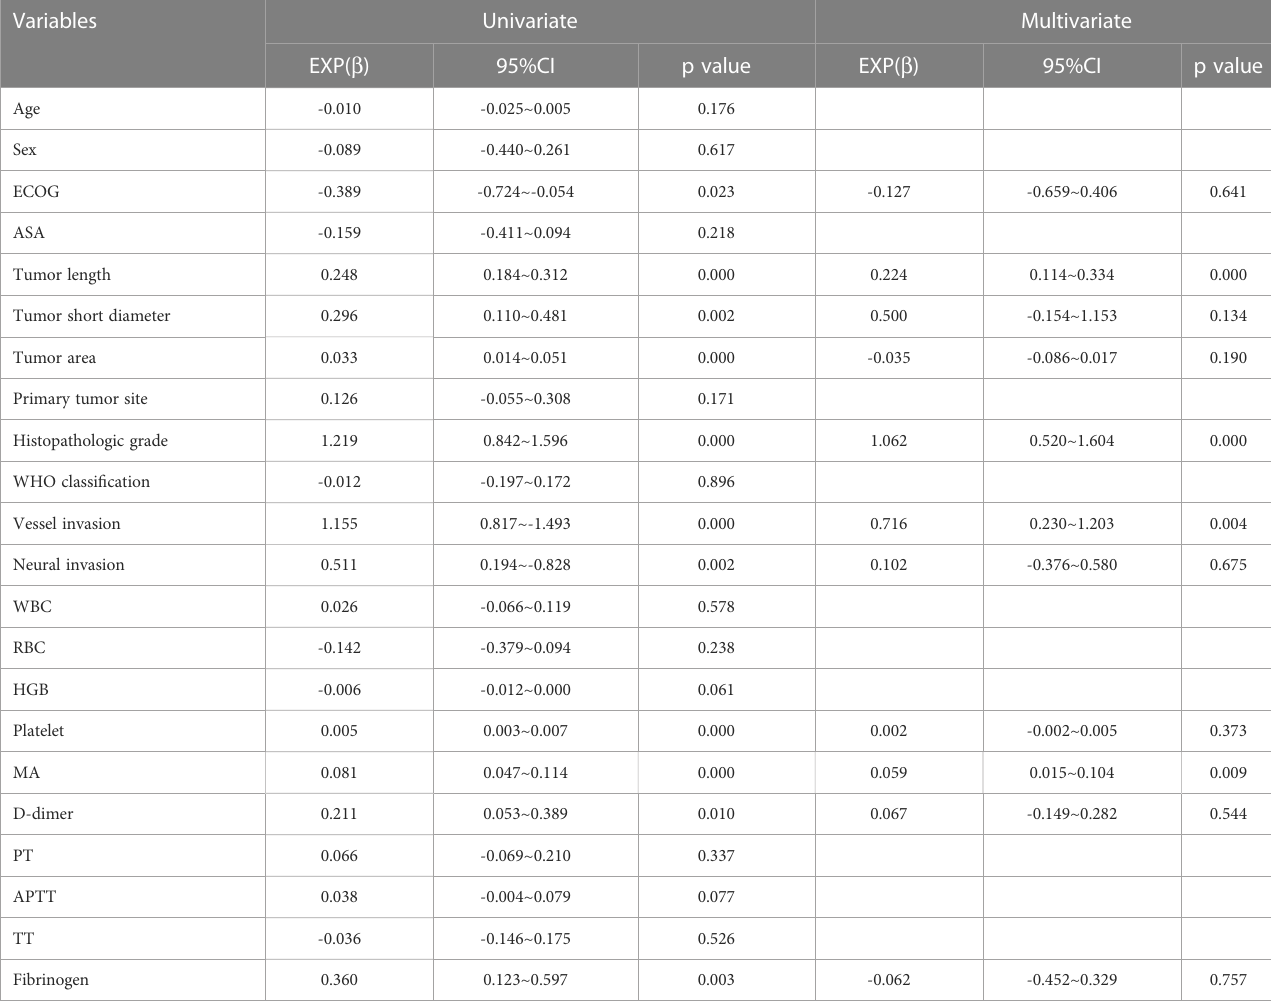
TABLE 5 In fl uencing factors of tumor N stage (N0/N1/N2/N3a/N3b) in patients with gastric cancer.